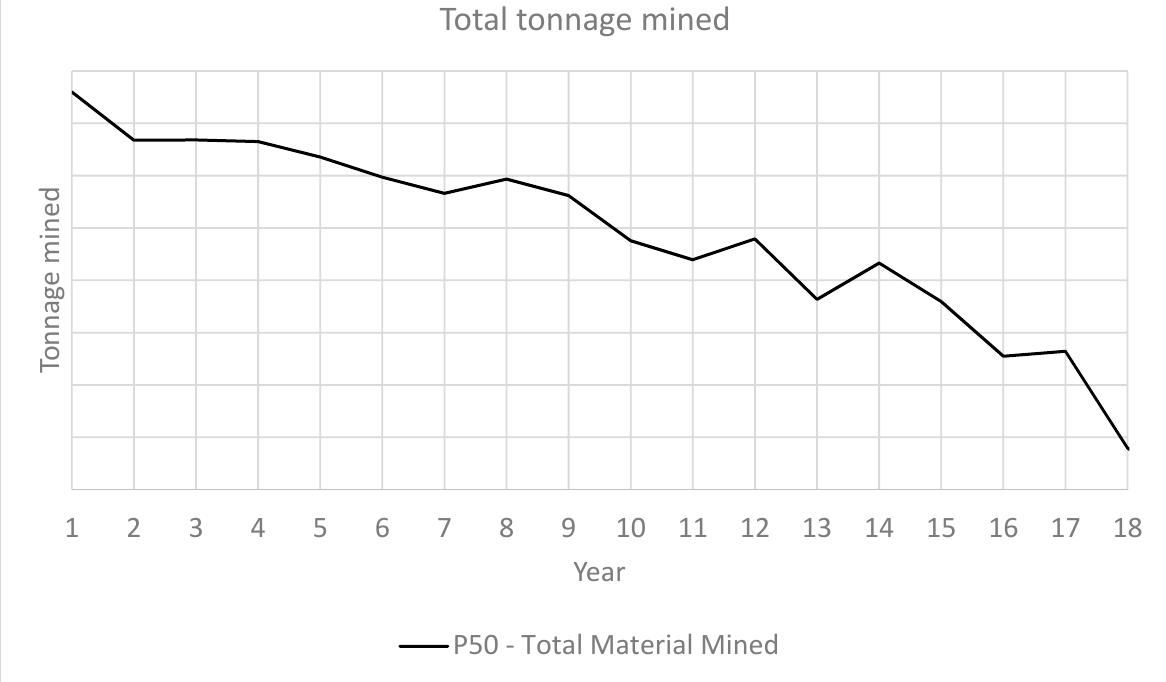
Figure 4. Total tonnage mined from the three mines at the RGM mining complex.